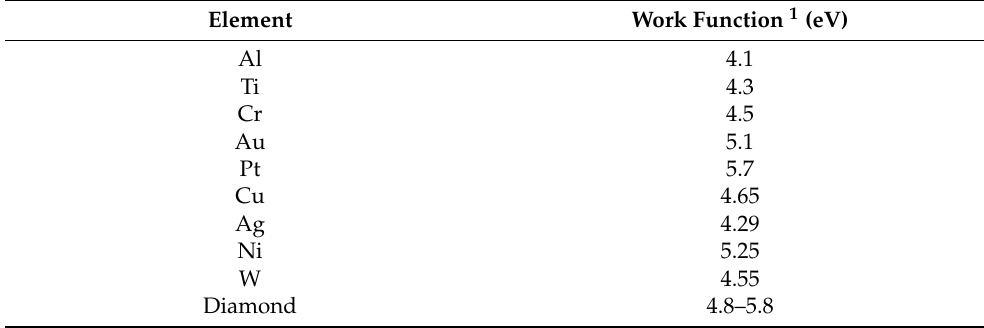
Table 2. Work function for some of the most used metals for depositing electrical contacts on diamond